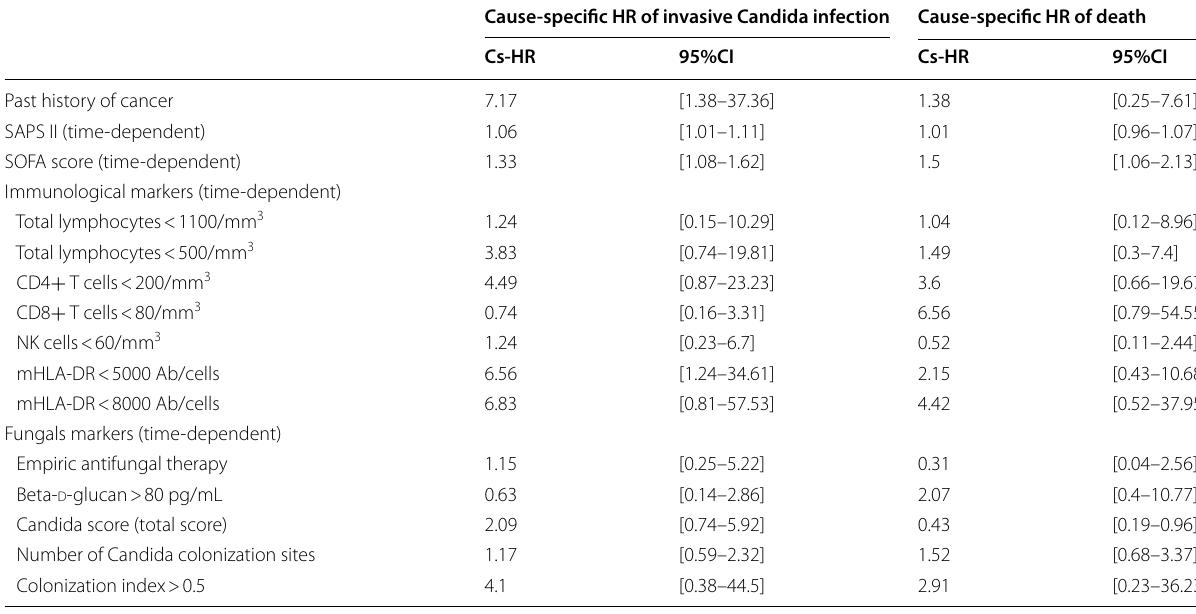
Table 2 Univariate cause-specific hazard ratio of invasive candida infection (competing risks: death, censored: alive discharge from ICU)